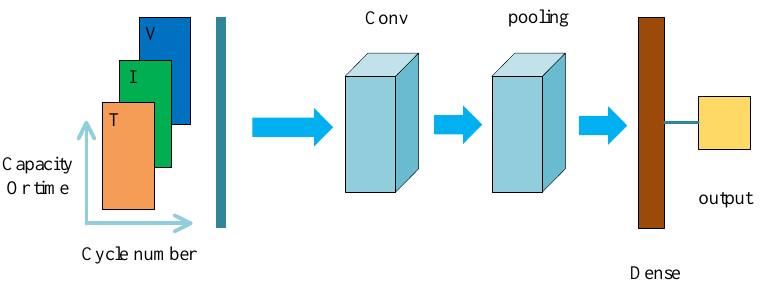
Figure 10. CNN basic